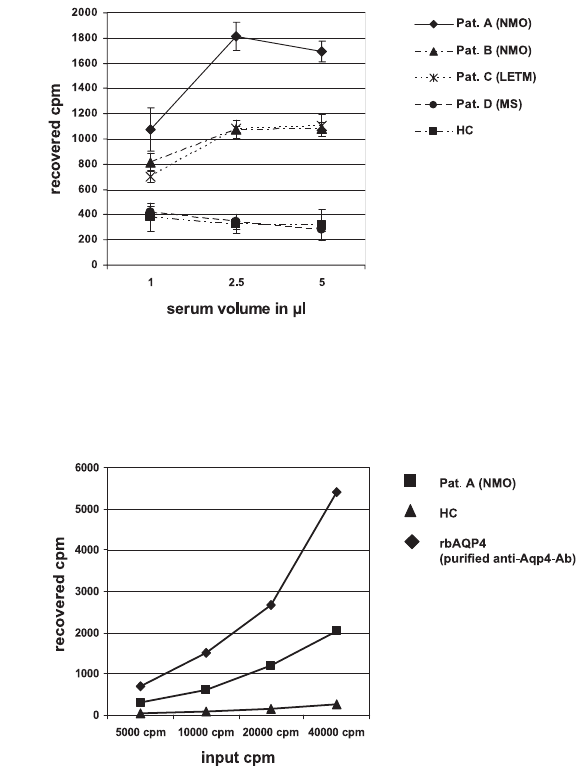
Figure 1. Characteristics of the Radioimmunoprecipitation Assay (A) Titration curve to assess the optimal serum volumes. Five samples are plotted: three positive (two NMO, one LETM) and two negative (one MS, one healthy control [HC]). While positive sera bound up to 1,800 cpm of 35 S-AQP4 with maximum binding at 2.5–5 l l, negative samples showed no more than 300–400 cpm of precipitation at all serum volumes. Values represent mean cpm of five independent measurements (error bars: SD). (B) Immunoprecipitation at different concentrations of 35 S-AQP4 (input cpm ranging from 5,000 to 40,000) of a positive serum (NMO), a negative serum (HC), and the rabbit serum rbAQP4 (5 l l per sample).